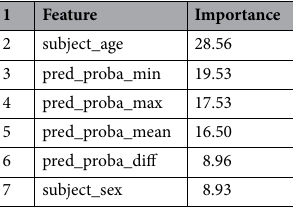
Table 3. Feature importance of the second-level basic model.